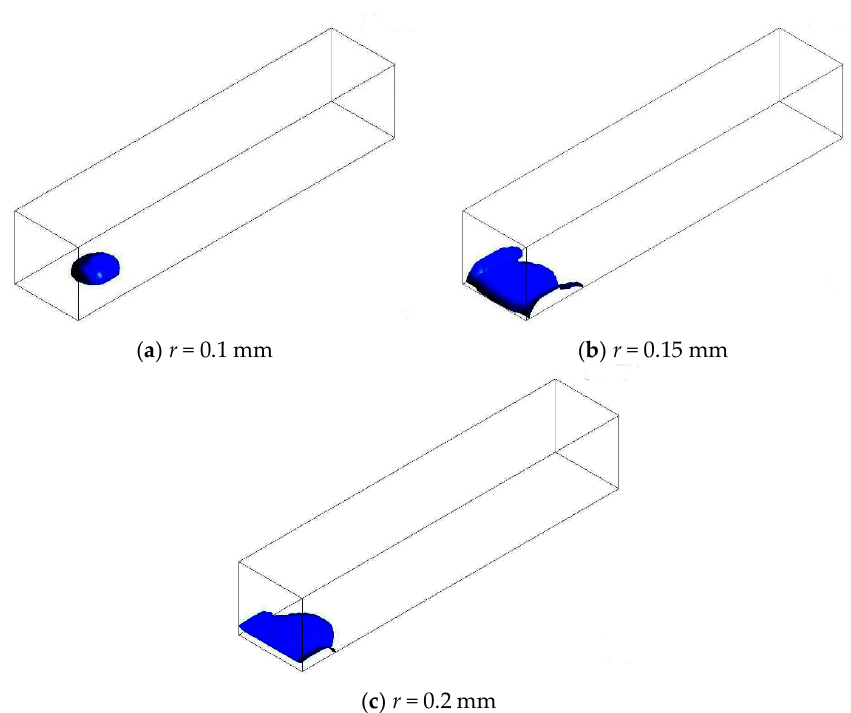
Figure 6. Water droplet behavior at different initial radius ( t = 1 ms and all the surface contact angles are 45°).